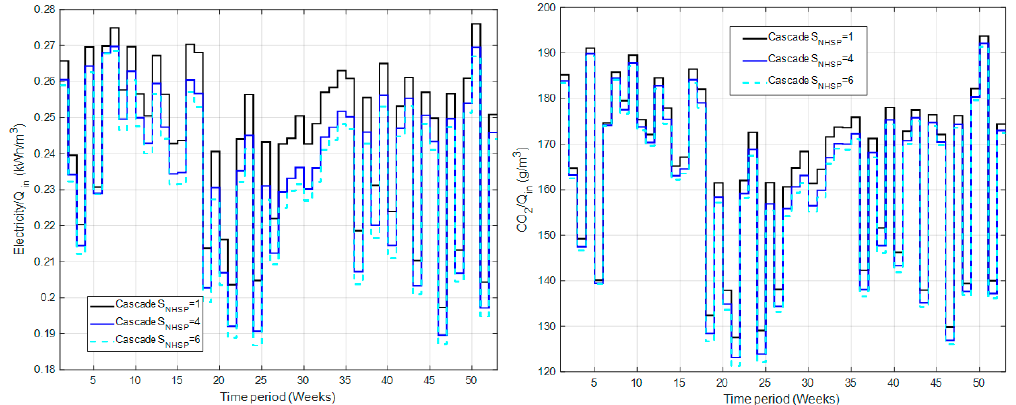
Figure 7. Weekly profiles for electricity consumption Electricity / Q in (kW h / m 3 ) and total carbon dioxide emissions CO 2 / Q in (g / m 3 ) under ammonium-based control scheme (Cascade S NHSP ).